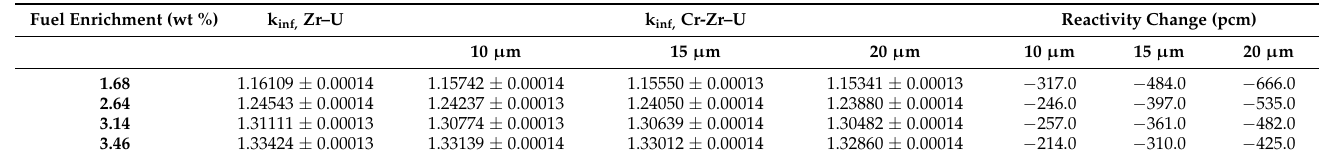
Table 5. k inf values at beginning of the cycle (BOC) for different pin cell enrichment for both types of cladding